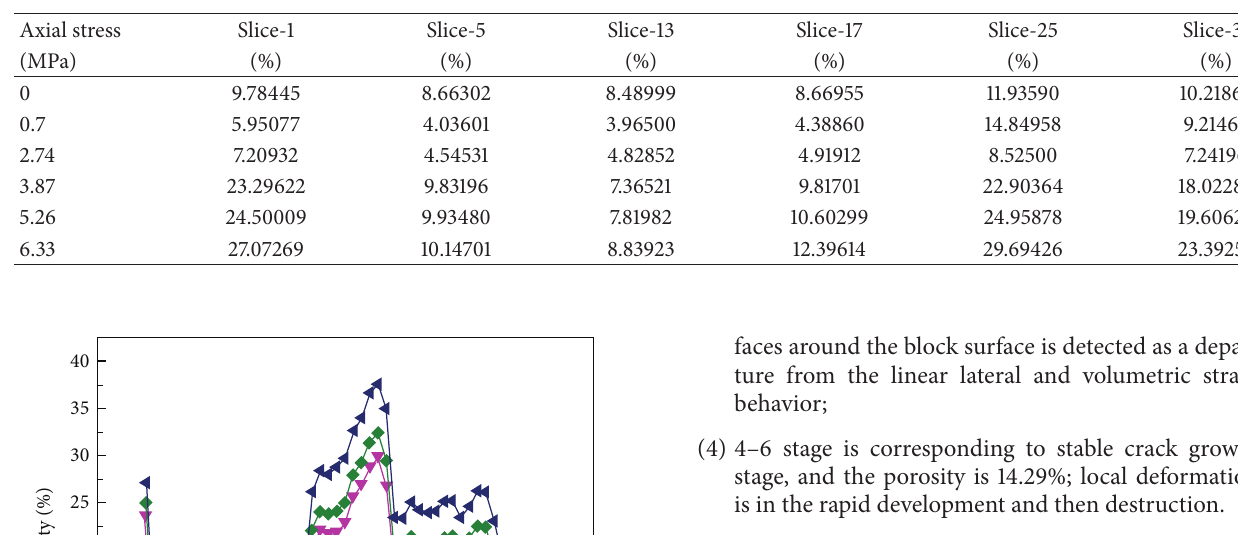
Table 1: The porosity calculation for typical CT slice under different stress level.